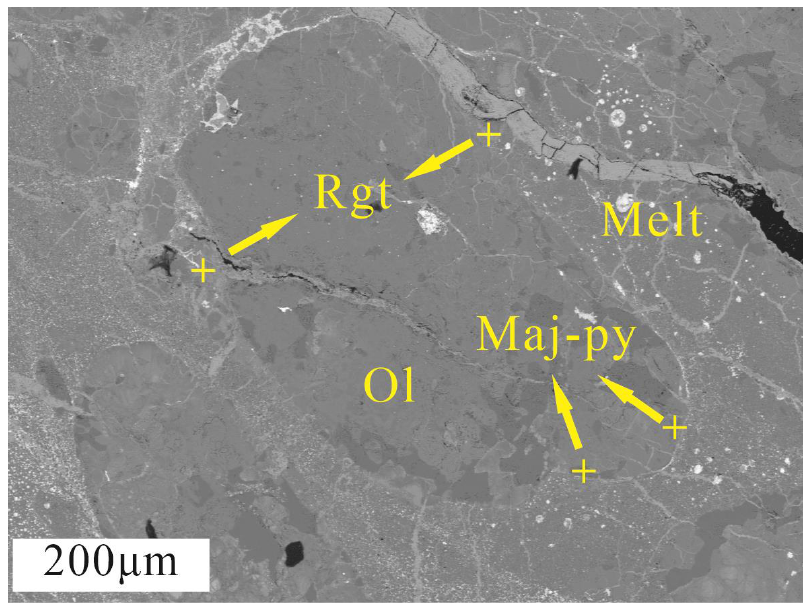
Figure 5. BSE images of ringwoodite and majorite-pyrope in sample GRV 090463. Rgt — ring- woodite; Maj-py — majorite-pyrope.